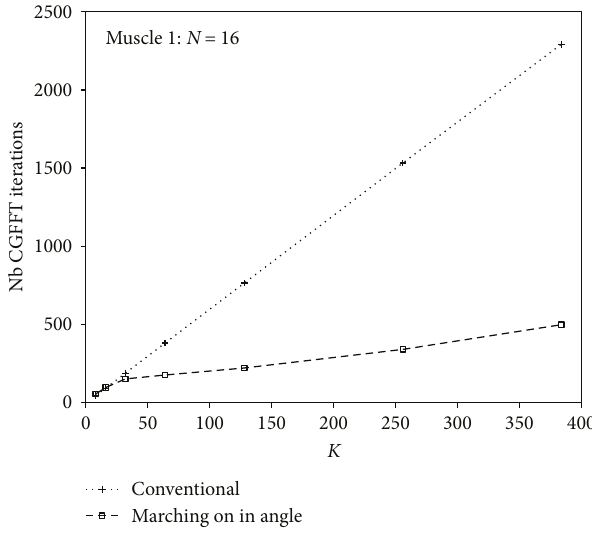
Figure 5: The total number of CGFFT iterations as a function of the number of sources K for the “ marching on in angle ” and conventional approaches, for Muscle1 with N = 16 . Table 3: The orders m = O and m = O for which the elements SP DP − 7 (single Q mm of the scattering matrix have dropped to fractions 10 precision) and 10 − 14 (double precision), respectively, of their maximum absolute value, for the homogeneous cylinders of Table